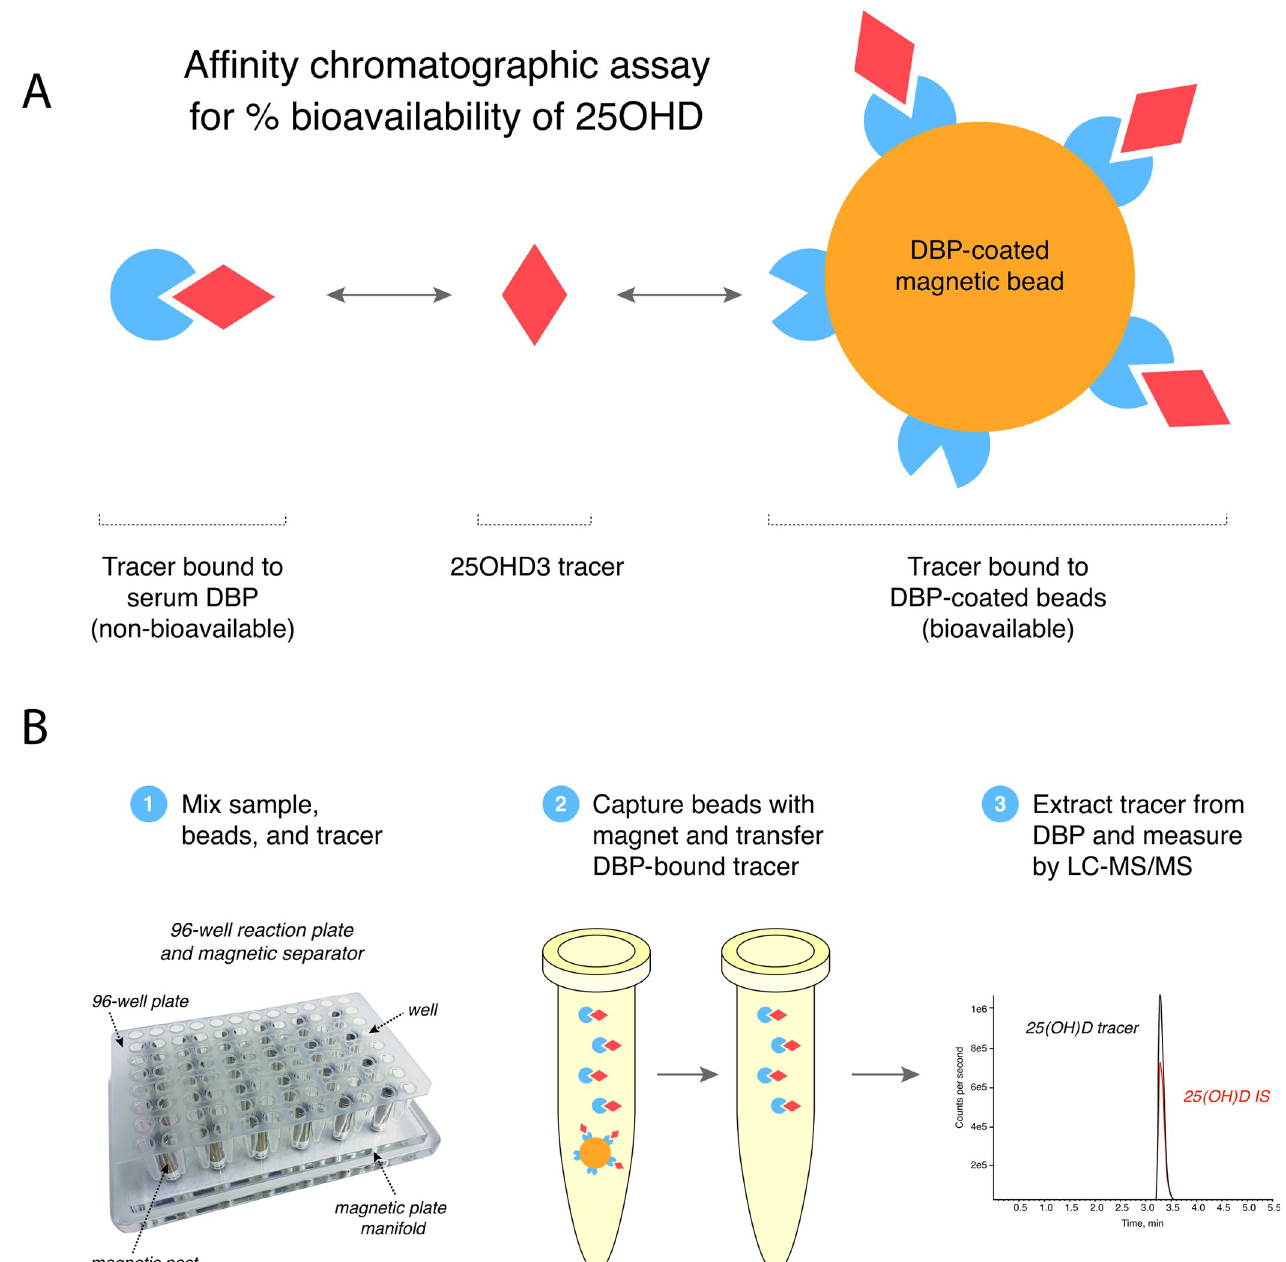
Fig 1. Assay for bioavailable 25OHD. (A) Graphic model of affinity chromatographic assay for % bioavailability of 25OHD. (B) Graphic illustration of methods for separation and measurement of DBP-bound 25OHD tracer from bioavailable 25OHD tracer by affinity chromatography on DBP-coated magnetic